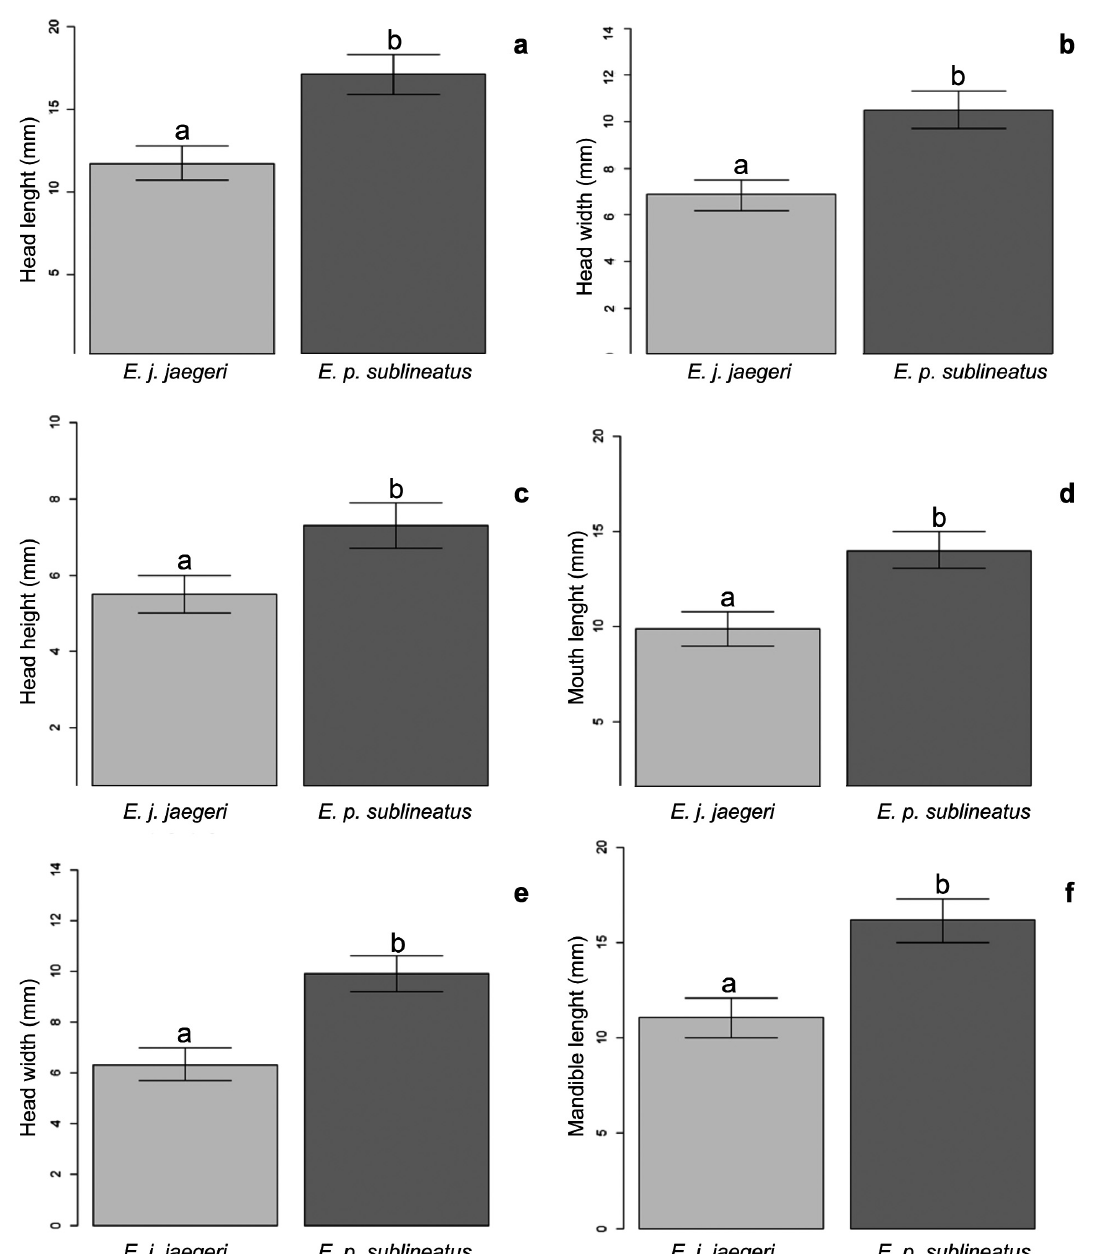
Figure 3 - Means ± standard deviation of head length ( a ), head width ( b ); head height ( c ), mouth length ( d ), mouth width ( e ), and mandible length ( f ) of Erythrolamprus jaegeri jaegeri and Erythrolamprus poecilogyrus sublineatus in the present